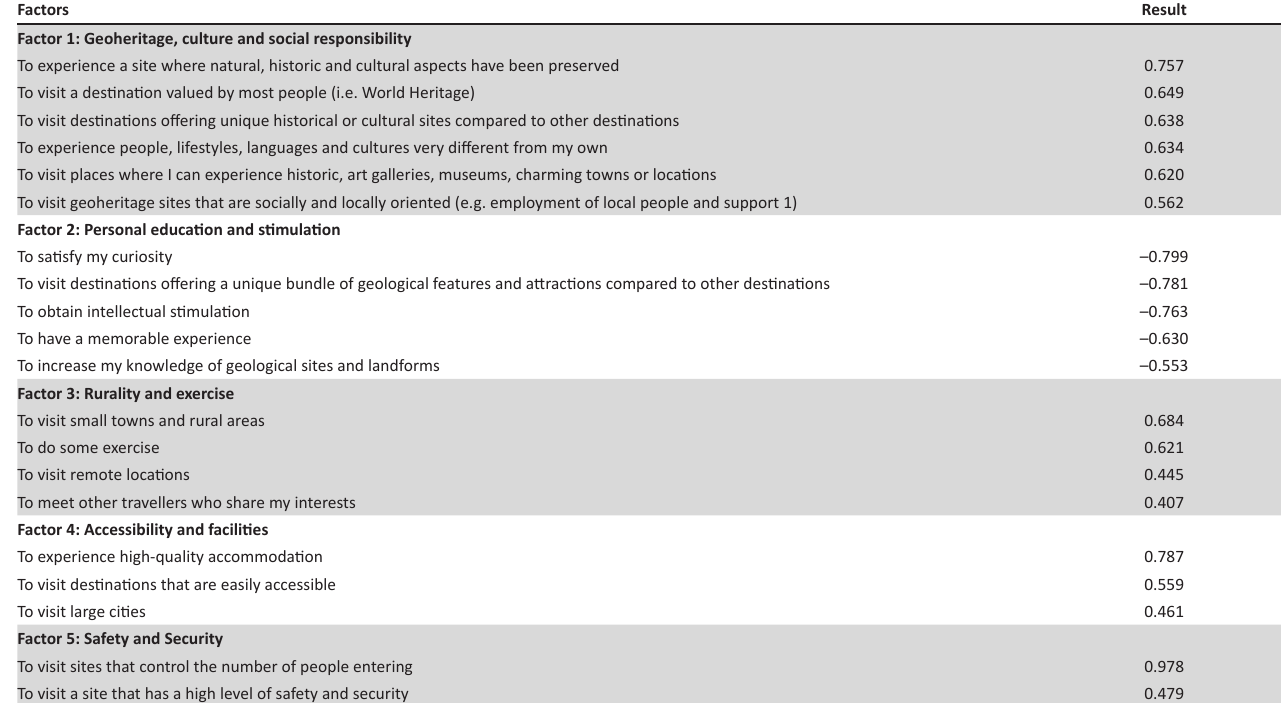
TABLE 2 : Factor analysis for motivation in relation to geotourism.